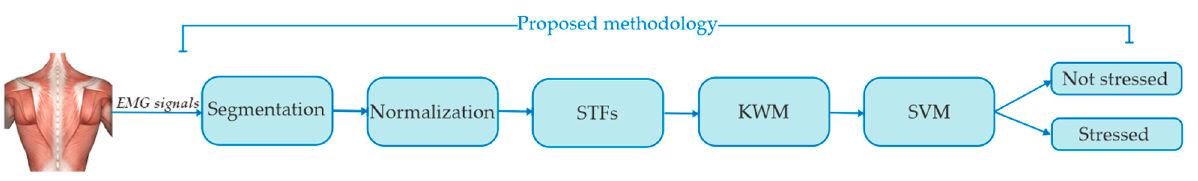
Figure 5. Schematic diagram of the proposed methodology.